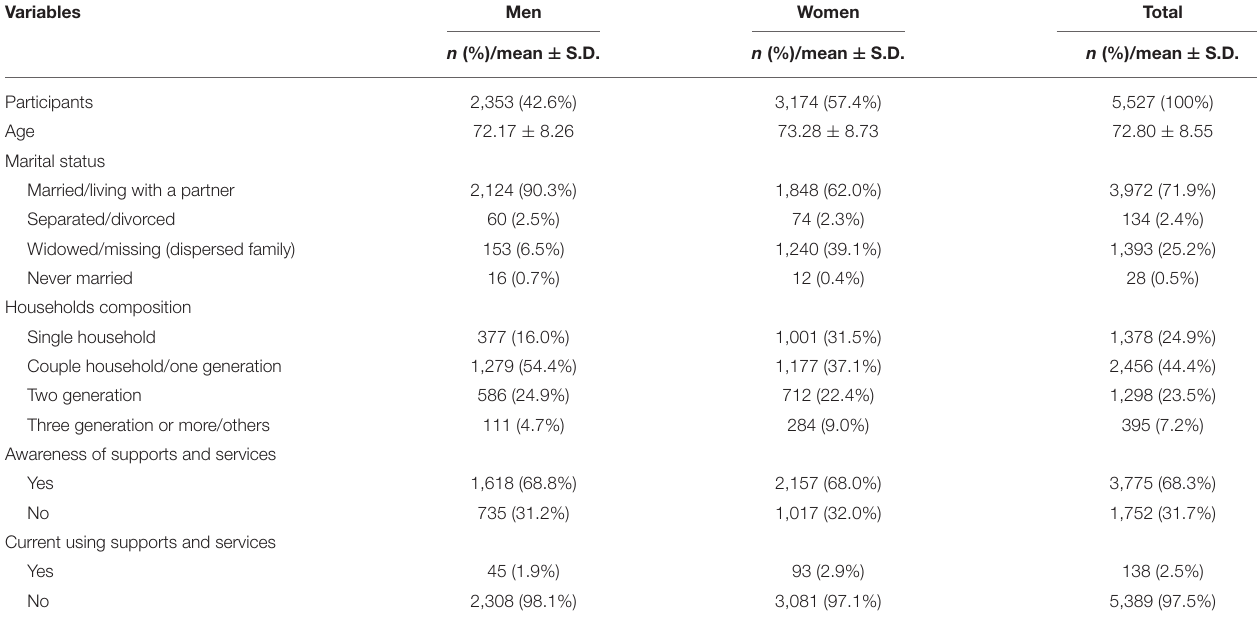
TABLE 1 | Participants’ descriptive